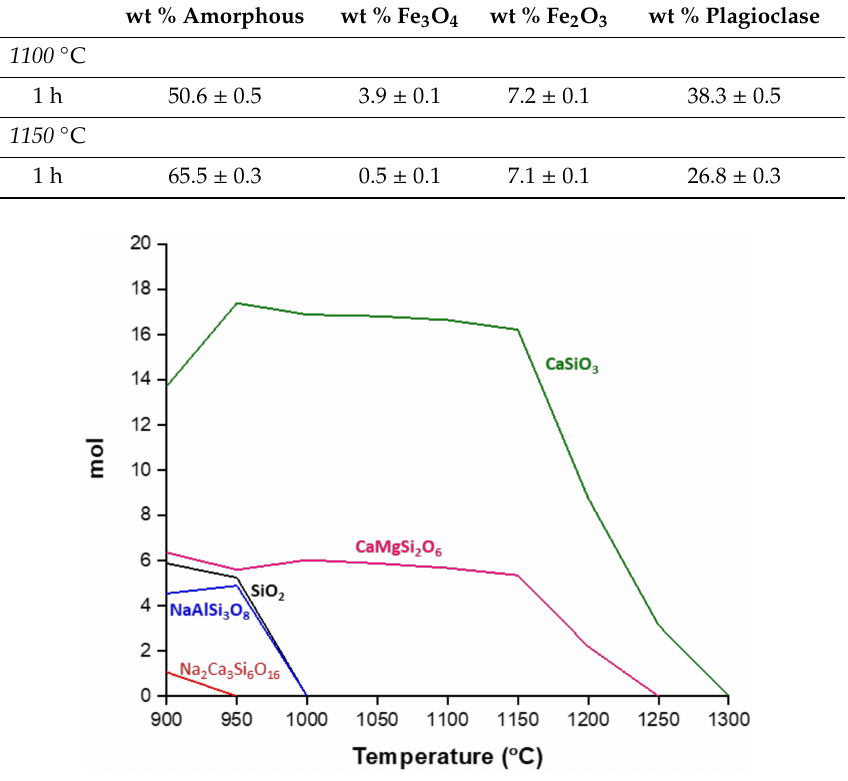
Figure 9. Expected phase formations in the synthetic sand glass as a function of temperature, calculated using the FactSage Equilibrium